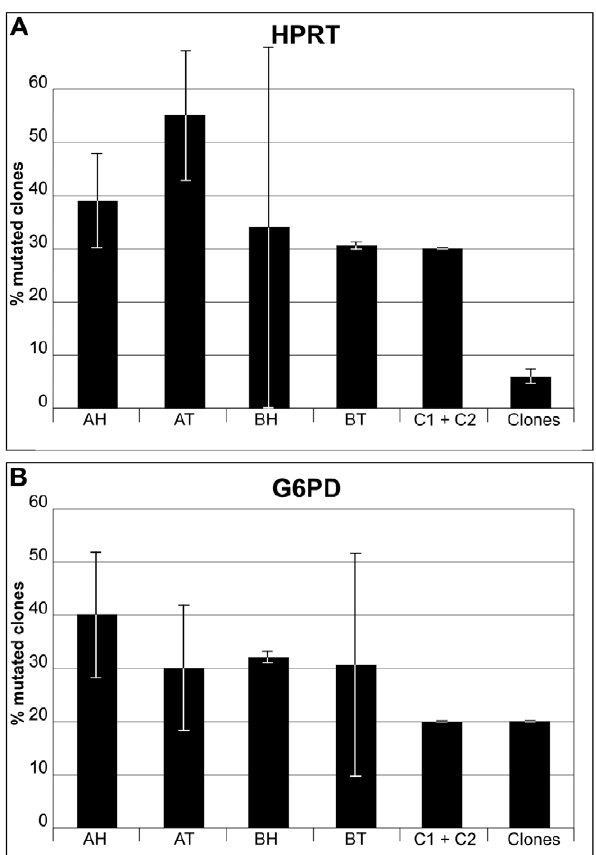
Figure 1. Standard deviations of percent mutated clones of HPRT and G6PD cDNAs. Analyses of 3 independent experiments for each gene on tumour and healthy tissues of patients A and B, on reference samples C1 and C2, and on control clones. Panel A, values of HPRT transcripts; Panel B, values of G6PD transcripts. AT and BT, values of clones of Tumour tissues; AH and BH, values of clones of Healthy tissues nearby tumours. Clones, values of control clones.